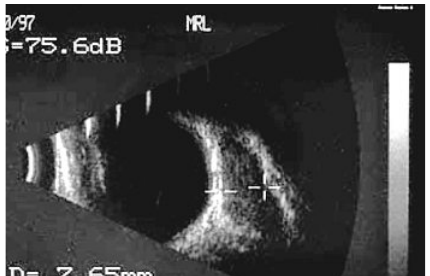
Transocular B-scan ultrasound with thick- ened extraocular muscle